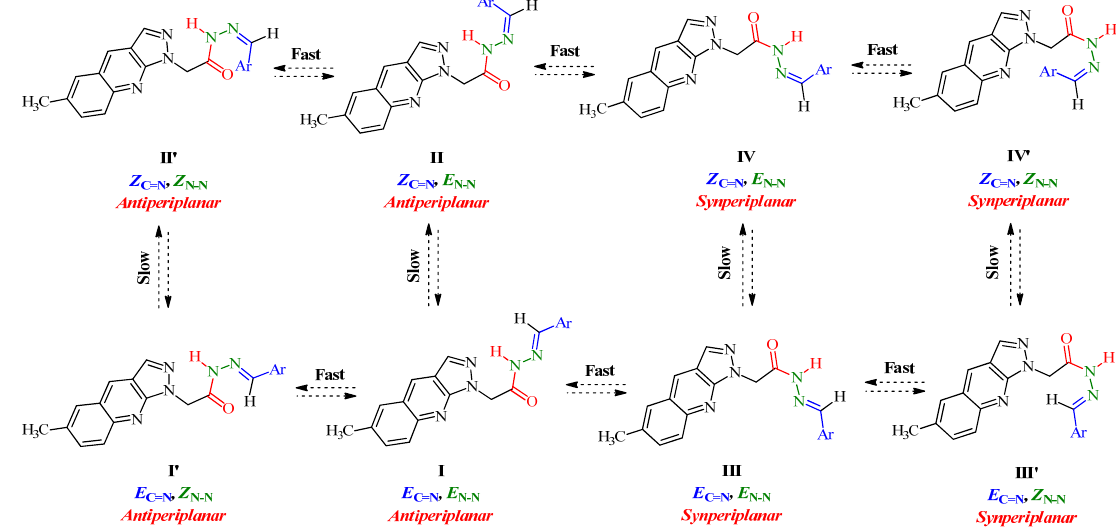
Figure 4. All the possible stereoisomers of N -Acylhydrazones 6 ( a – t ).